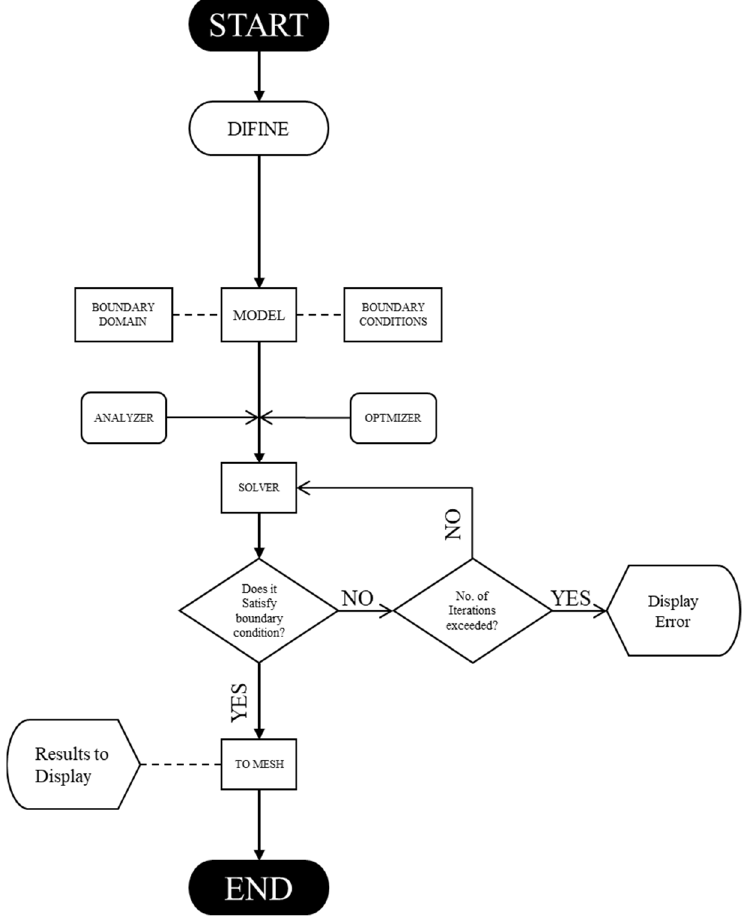
Figure 1. Process map for the flow of optimisation using Rhino 7.